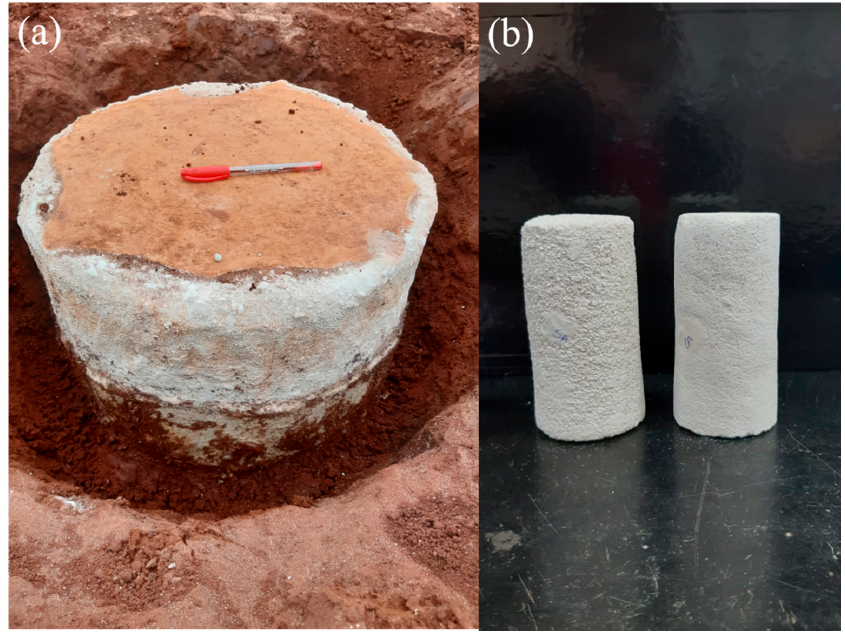
Figure 4. General procedure followed to retrieve samples for laboratory testing ( a ) starting with the side excavation of the field sample; ( b ) from which several cylindrical specimens were then collected with manual trimming.